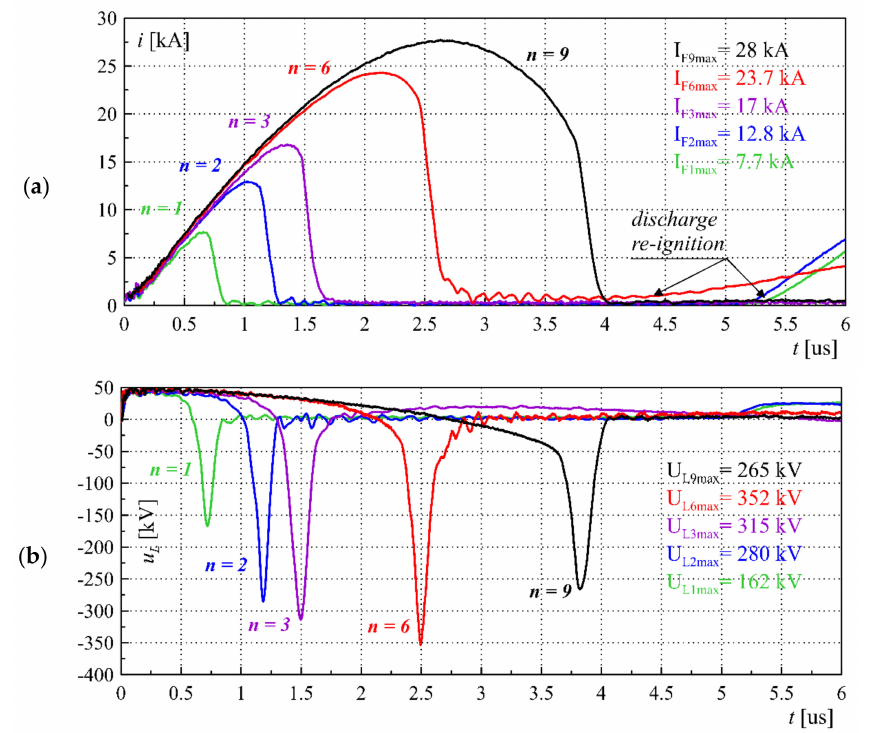
Figure 10. Selected waveforms of the fuse current i ( a ), and the voltage across the forming coil u L ( b ) for different numbers of fusible elements